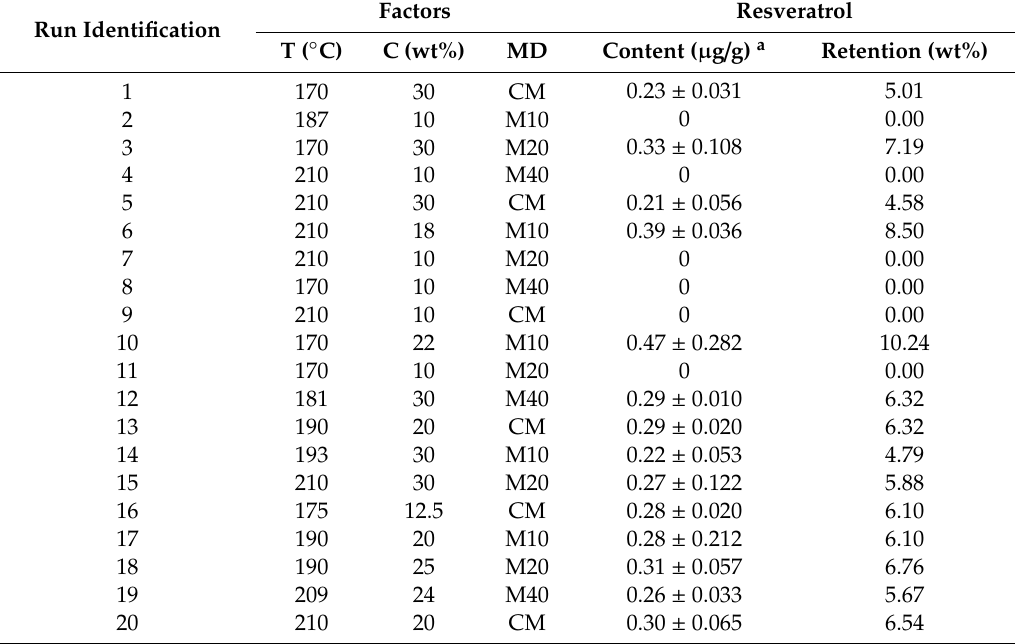
Table 2. Content and retention of resveratrol in spray drying of blueberry juice-maltodextrin (BJ-MX). Run